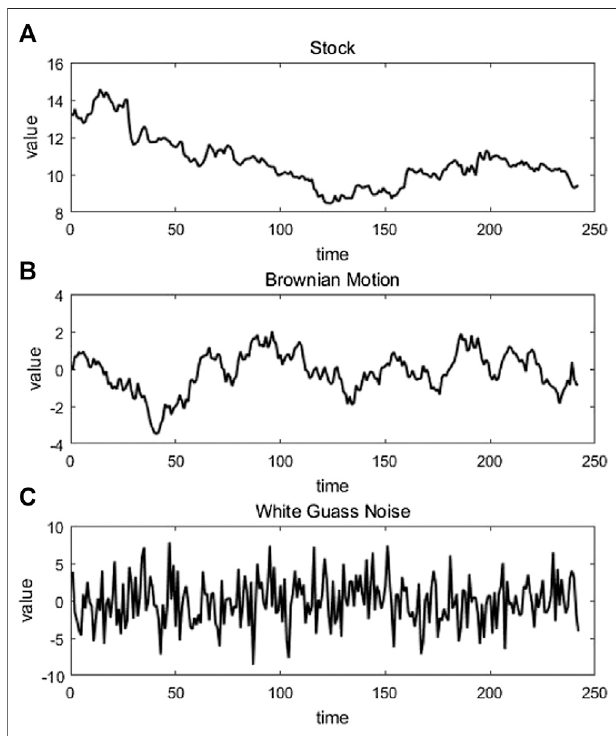
FIGURE3| Threetypesofrepresentativetimeseriesdata. (A) stock, (B) Brownian motion, and (C) Guass noize.